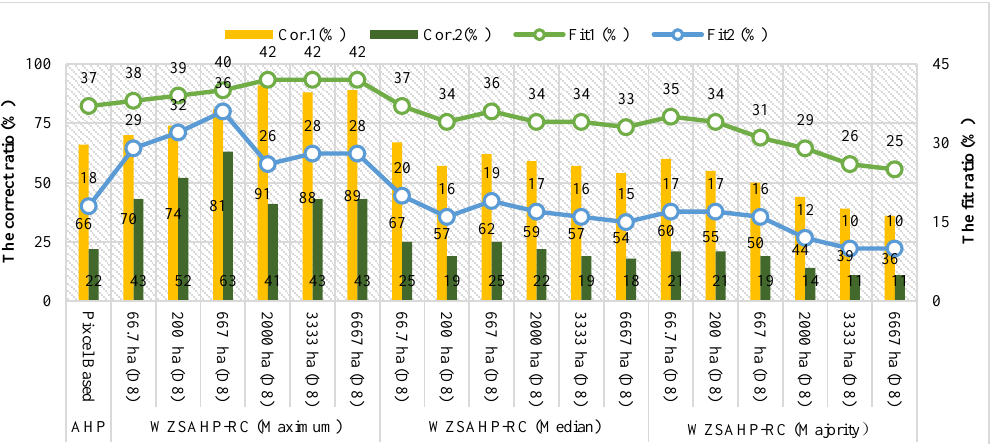
Figure 11. The correct ratio and fit ratio values of pixel-based AHP and the WZSAHP-RC using D8 derived sub-watershed to constrain converging related indicators.